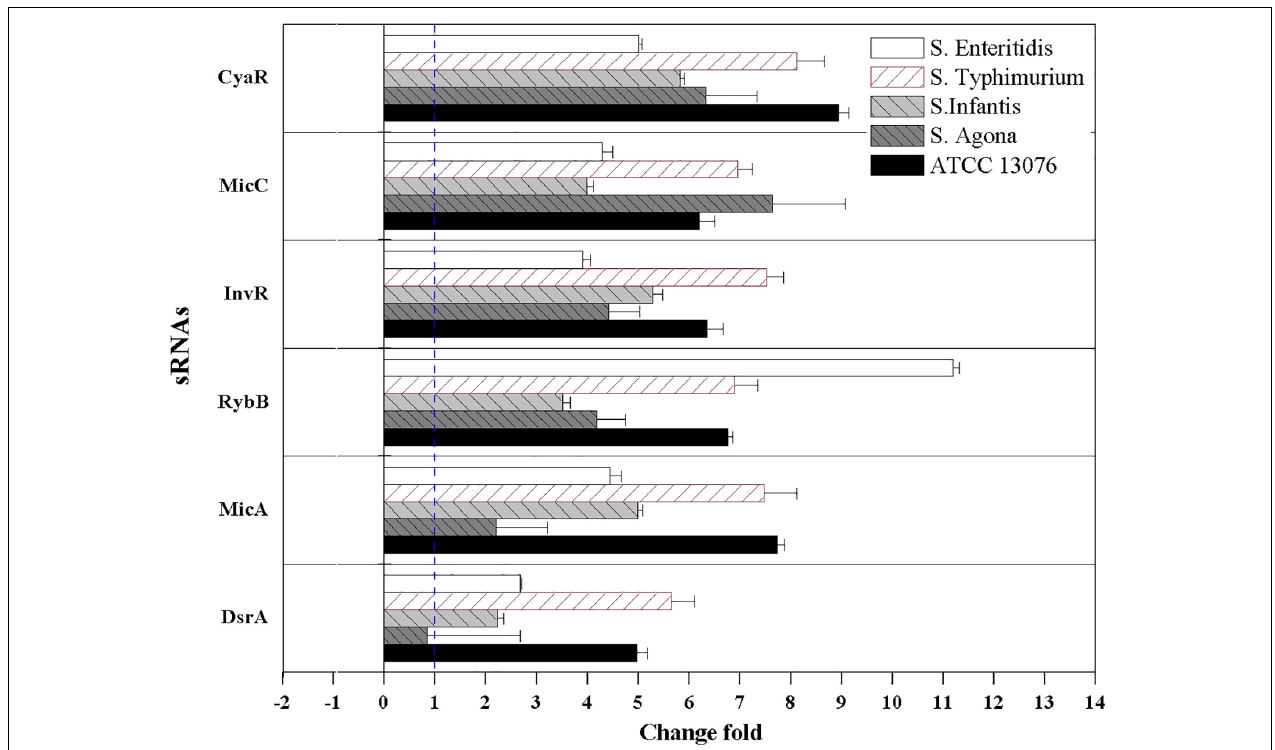
FIGURE 4 | The relative expression of sRNAs of Salmonella strains when exposed to acidic stress. Each symbol indicates the mean ± standard deviation of five independent experiments ( n = 5).